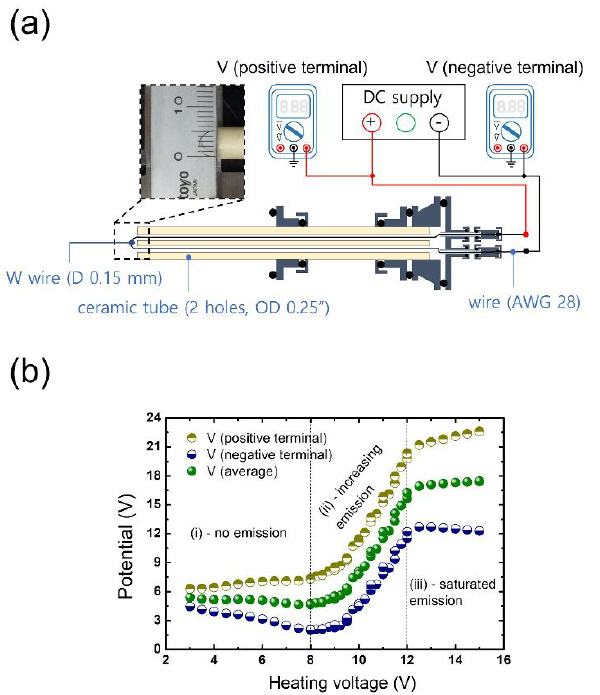
Figure 4. ( a ) Schematic of the emissive probe measurement system and ( b ) characteristic potential vs. heating voltage plot of the emissive probe.